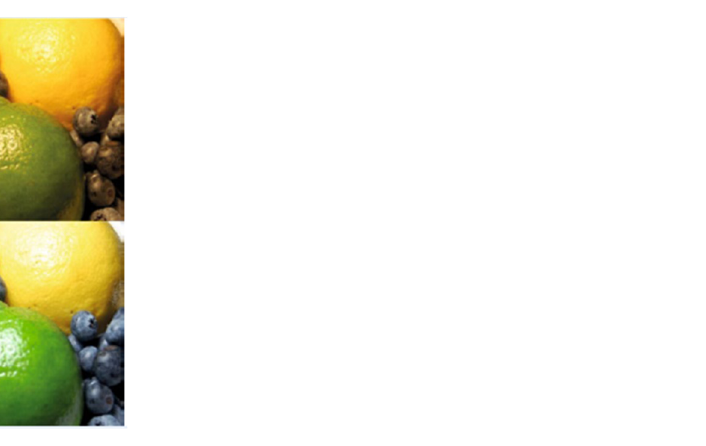
Figure 2. Difference in colour-rendering capabilities between high and low CRI. Reprinted with permission from Ref. [6] . 2017, Springer Nature: Nature Energy.